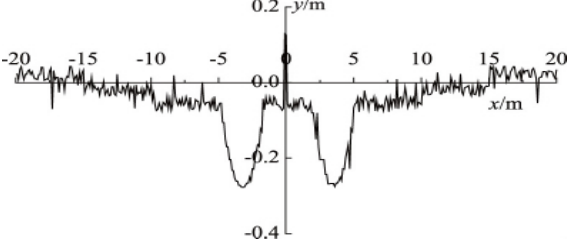
Figure 8. Measured transverse wheel track curve after signal processing.